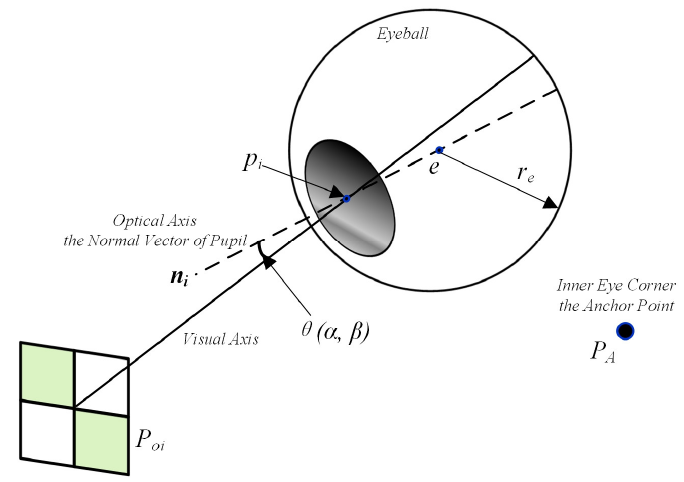
Figure 7. Single 3D eye model in this method and the main eyeball features.